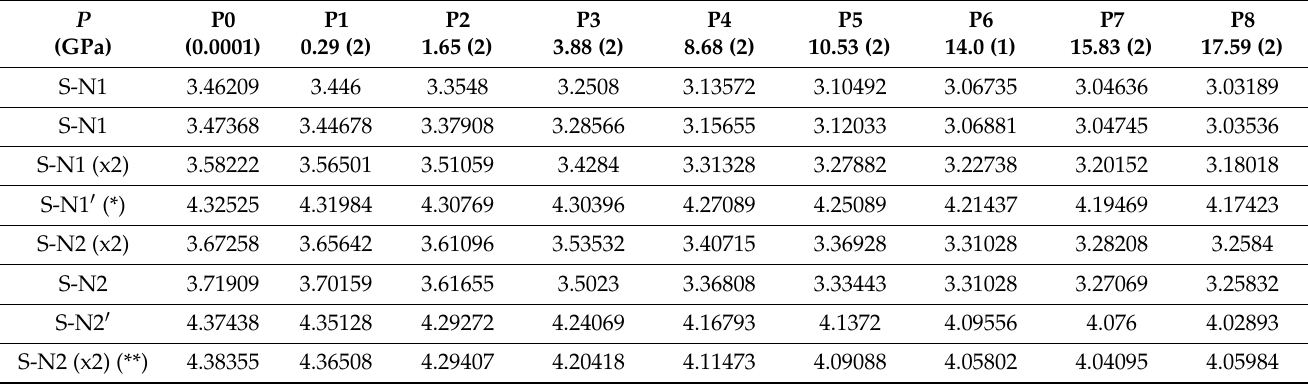
Figure 5. Evolution with pressures of sulfur-nitrogen distances. Values are given relative to their zero-pressure values. * S-N1′ principal component along the x axis. ** S-N2 principal component along the y axis. 4. Discussion The present data thoroughly describes the main structural evolution of mascagnite and explains the anisotropic compression observed in lattice parameters. The following considerations are outlined: